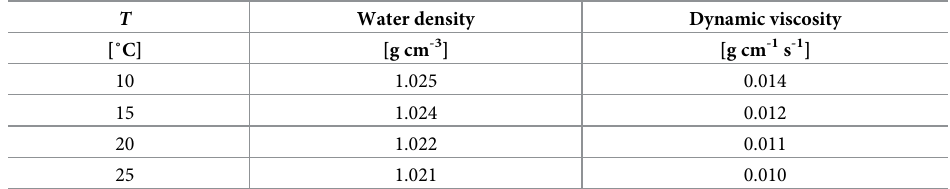
Table 1. Seawater density and seawater dynamic viscosity.